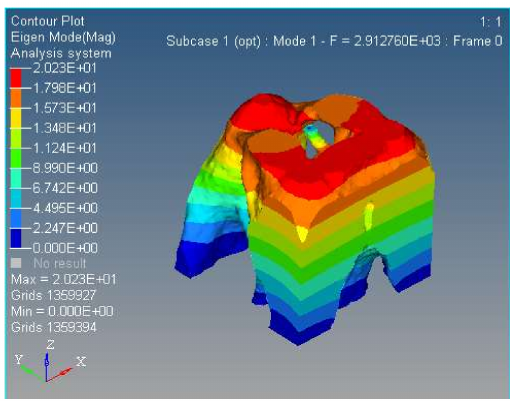
Figure 12. First order modal of the proposed spatially compliant mechanism with